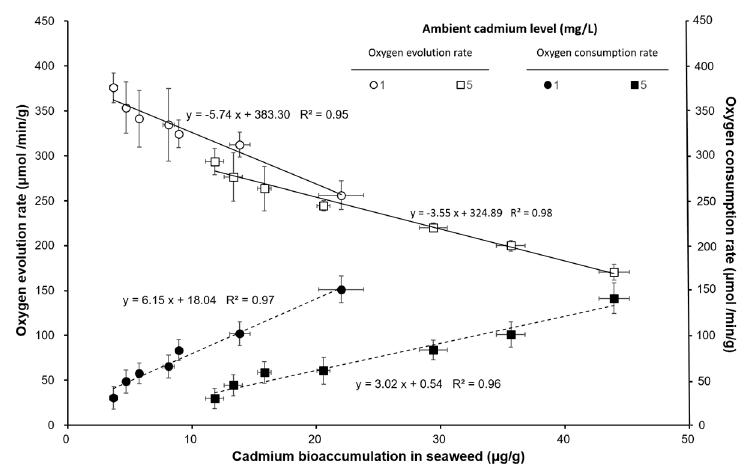
Figure 4. The relationship between the oxygen evolution rate ( μ mol/min/g) and oxygen consumption rate ( μ mol/min/g) with cadmium content on seaweed bioaccumulation ( μ g/g) in S. suiae exposed to 1 and 5 Cd 2+ mg/L.